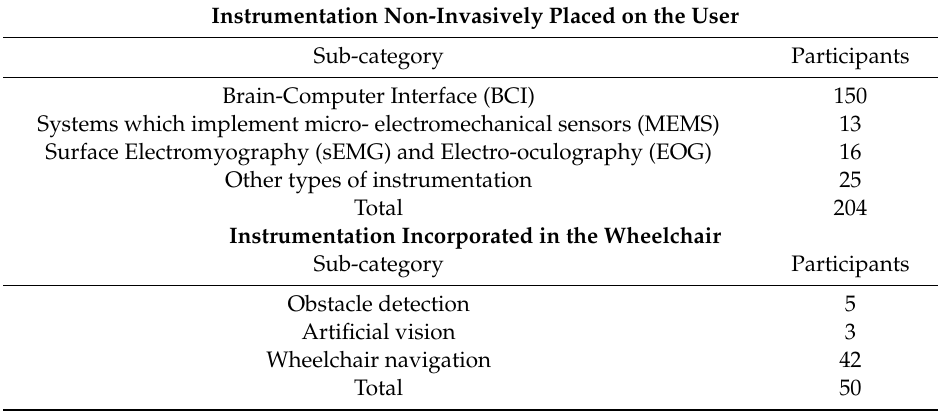
Table 3. Number of participants per